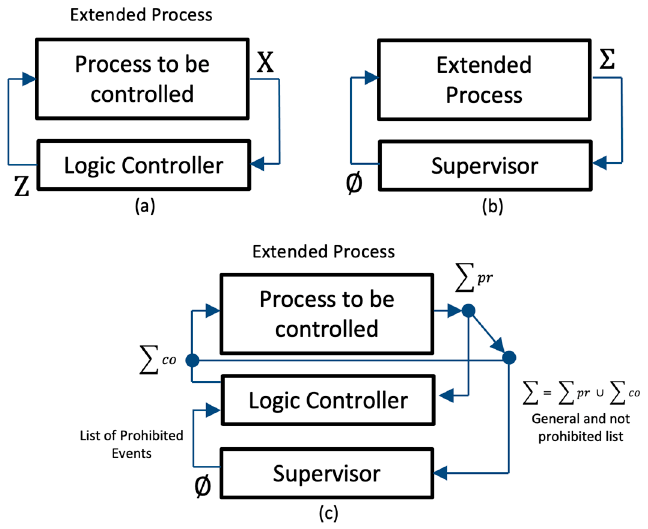
Figure 7. Supervised control. ( a ) The extended process. ( b ) The supervisor’s scheme. ( c ) The supervised control scheme [65].